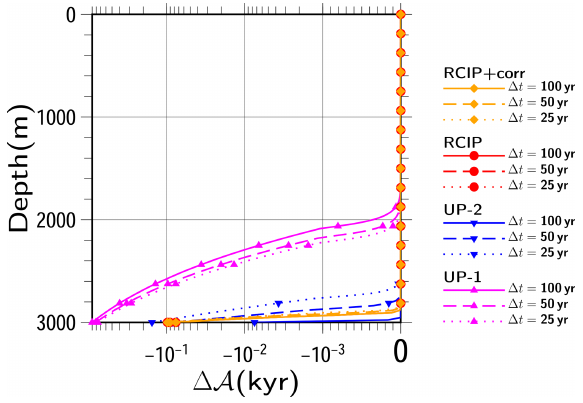
Figure 3. Experimental results obtained using a uniform velocity of w = 15cmyr − 1 . Snapshots of computed vertical age profiles ob- tained by RCIP with correction, RCIP, second-, and first-order up- wind schemes at t = 20kyr relative to the exact solution are shown. The results of different time steps of 100, 50, and 25 years are shown for each scheme. The results of RCIP with correction are identical to those of RCIP. Age differences are shown on a logarithmic scale, except for those near 0, which are shown on a linear scale. Symbols are plotted for every eight vertical